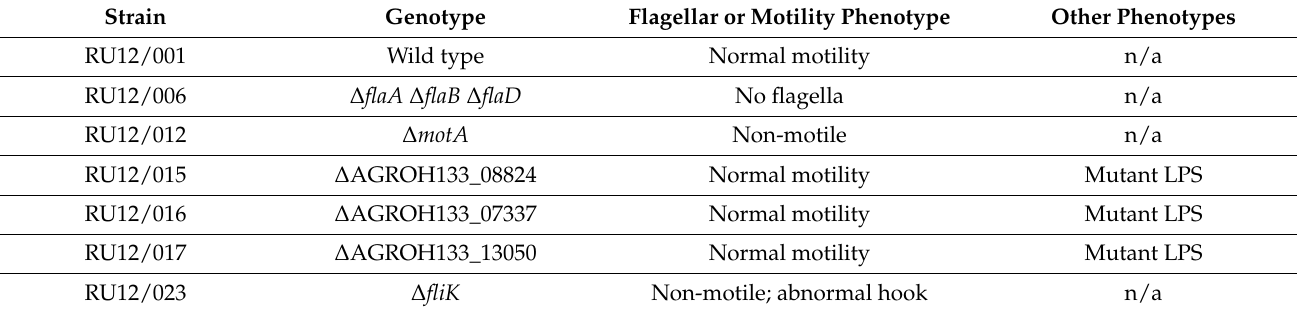
Figure 7. Lawn clearance experiments with Gp4 1-247 . TYC plates overlaid with TYC top agar (0.5% agar) containing wild-type and various phage resistant mutant strains received 10 µ L spots of PBS, different concentrations of Gp4 1-247 , or phage 7-7-1 (10 7 PFU). Following overnight incubation at 30 ◦ C the plates were assessed for spots of clearance and imaged. The genotypes and resulting phenotypes for each strain are listed in Table 5. Table 5. Agrobacterium sp. H13-3 strain genotypes and resulting flagellar and motility associated properties.